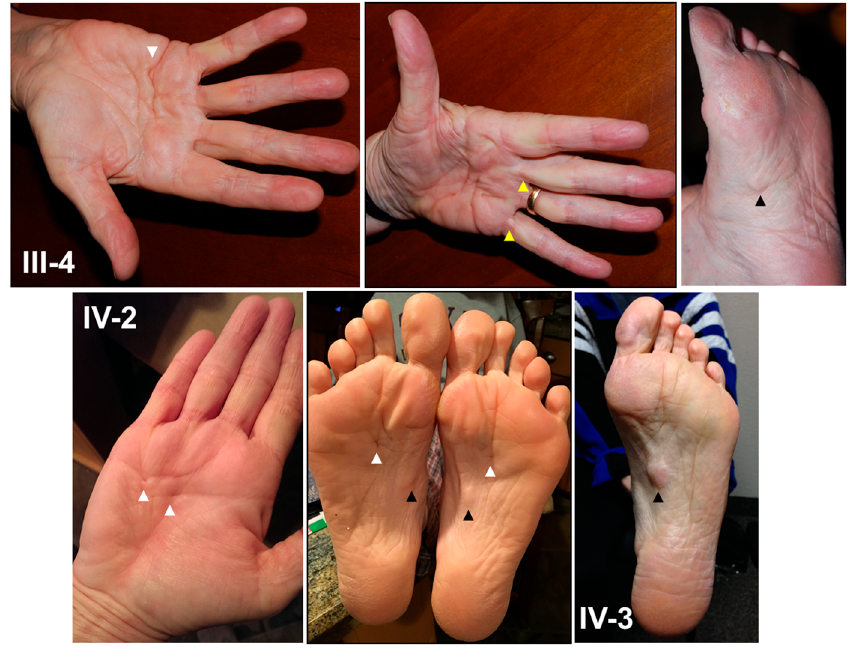
Figure 2. Dupuytren’s and Ledderhose disease. Photographs: (top panel) right hand, left hand, and left foot of the aunt ( III-4 ), (bottom panel, left-middle) right hand and feet of the proband ( IV-2 ) and (bottom panel, right) left foot of the sister ( IV-3 ) with skin tethering/puckering or dimpling (white arrows), cord formation (yellow arrows), and central medial plantar nodules (black arrows). An image from one additional family member (Patient 3) was removed after consent to publish was declined.